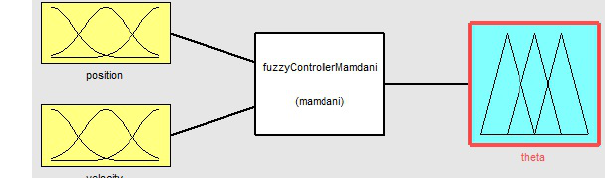
Figure 8: Fuzzy Logic Mamdani.